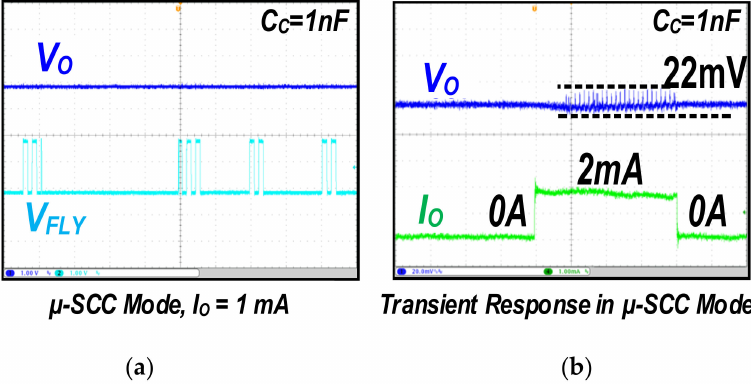
Figure 13. Measurement of ( a ) steady-state waveforms and ( b ) transient response in µ -SCC mode for V DD = 3.7 V and V O = 1.8 V ( C C = 1